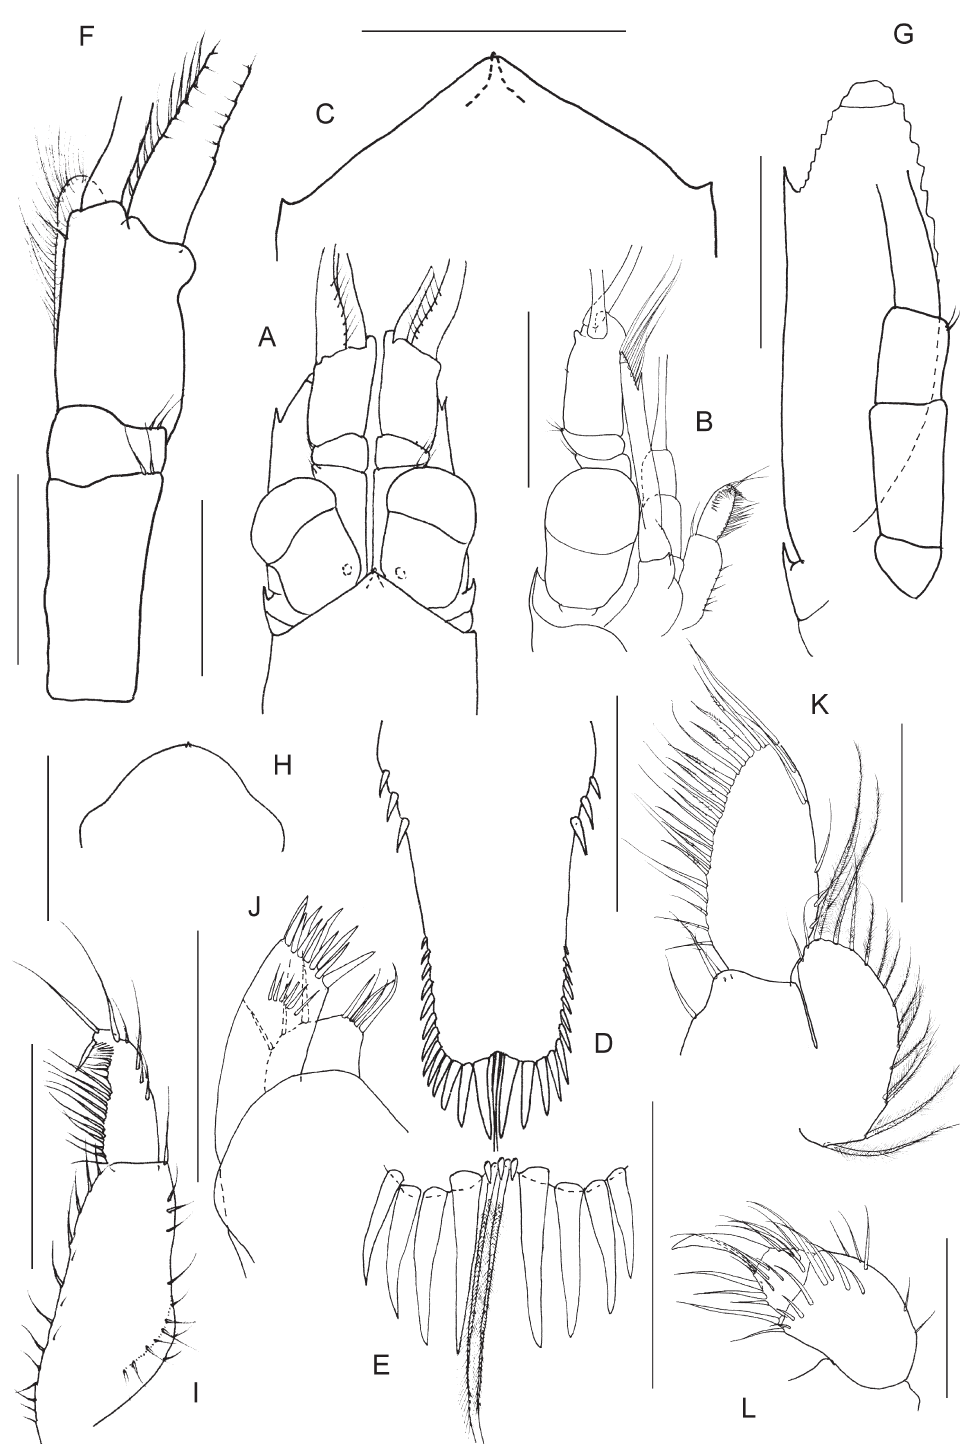
Fig. 18. Siriella occulta sp. nov., holotype, ♂, length 6.5 mm, Arabian Gulf, Saudi Arabia. A . Anterior part of body, dorsal view. B . Anterior part of body, lateral view. C . Anterodorsal margin of carapace. D . Telson. E . Posterior part of telson, ventral view. F . Peduncle of antenna 1, dorsal view. G . Antennal scale and peduncle of antenna 2, ventral view. H . Labrum. I . Mandibular palp, medial view. J . Maxilla 1, posterior view. K . Maxilla 2 (endites not shown), anterior view. L . Distal part of maxilliped 1, anterior view. Scale bars: A– B = 0.5 mm; C, E, H, J–L = 0.1 mm; D, F –G, I = 0.25